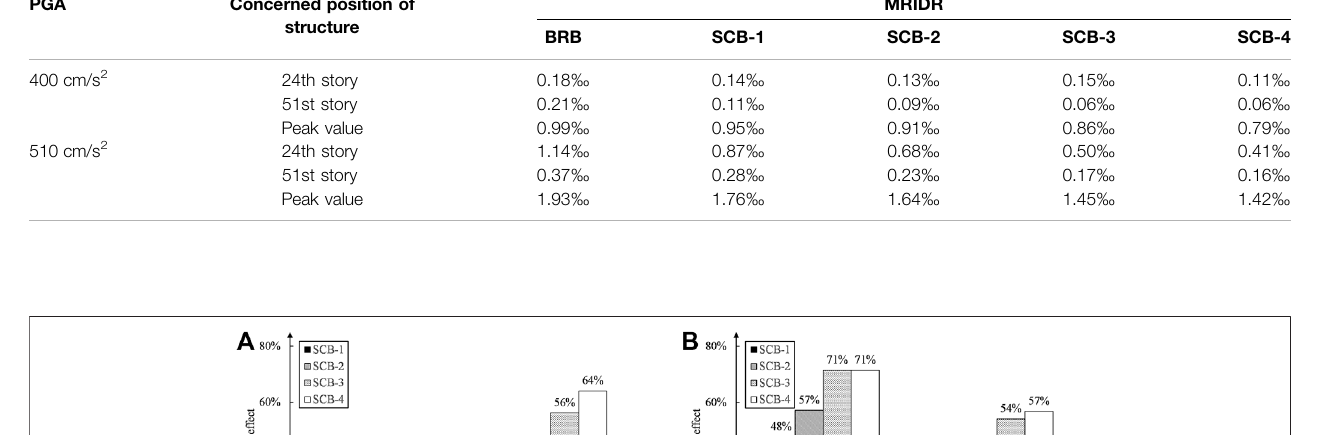
Frontiers in Materials |